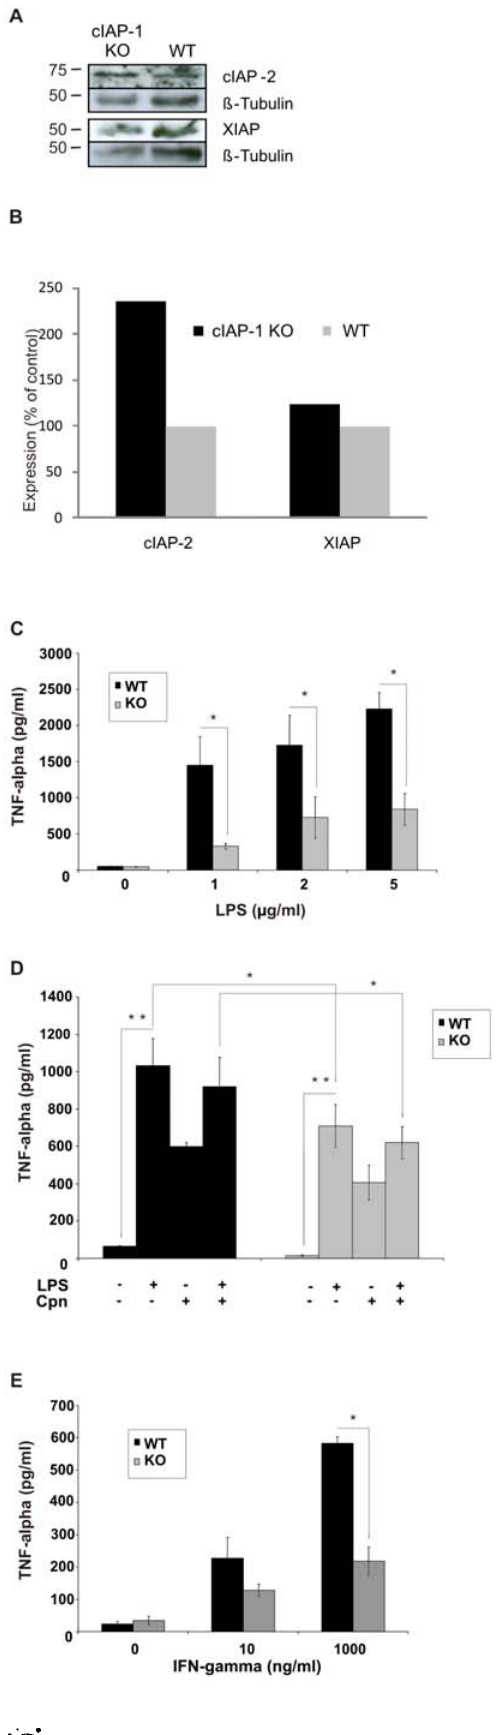
Figure 3. cIAP-1 is required for endotoxin- (LPS) and IFN- c - induced inflammatory response. A. cIAP-2 is upregulated in the lungs of knockout mice. Lung homogenates from wildtype ad knockout mice were subjected to immunoblot analysis for the quantification of cIAP-2 and XIAP as described in Materials and Methods. b -tubulin was detected as a loading control. B. Densitometric quantification of the data shown in figure 3A normalized for b -tubulin as loading control. C. The isolated peritoneal macrophages from both wildtype and cIAP-1 KO mice were treated with different doses of LPS, and TNF- a was determined in the culture supernatants 48 h post treatment. Data represent the mean 6 SEM from three independent experiments. D. Impaired TNF- a production in infected cIAP-1 KO macrophages. Macrophages were cultured and infected with C. pneumoniae at MOI 1 and/or treated with LPS at 5 m g/ml. TNF- a titers were determined in the culture supernatants 48 h post infection and treatment. Data are presented as the mean 6 SE from three independent experiments. E. cIAP-1 is required for IFN- c -mediated production of TNF- a . Peritoneal macrophages from wildtype and cIAP-1 KO mice were isolated and stimulated with different doses of mouse IFN- c ex vivo . The supernatant were collected at 48 h after stimulation and TNF- a titers were quantified by ELISA. Data represent the mean 6 SEM from two independent experiments. * p # 0.05; ** p #